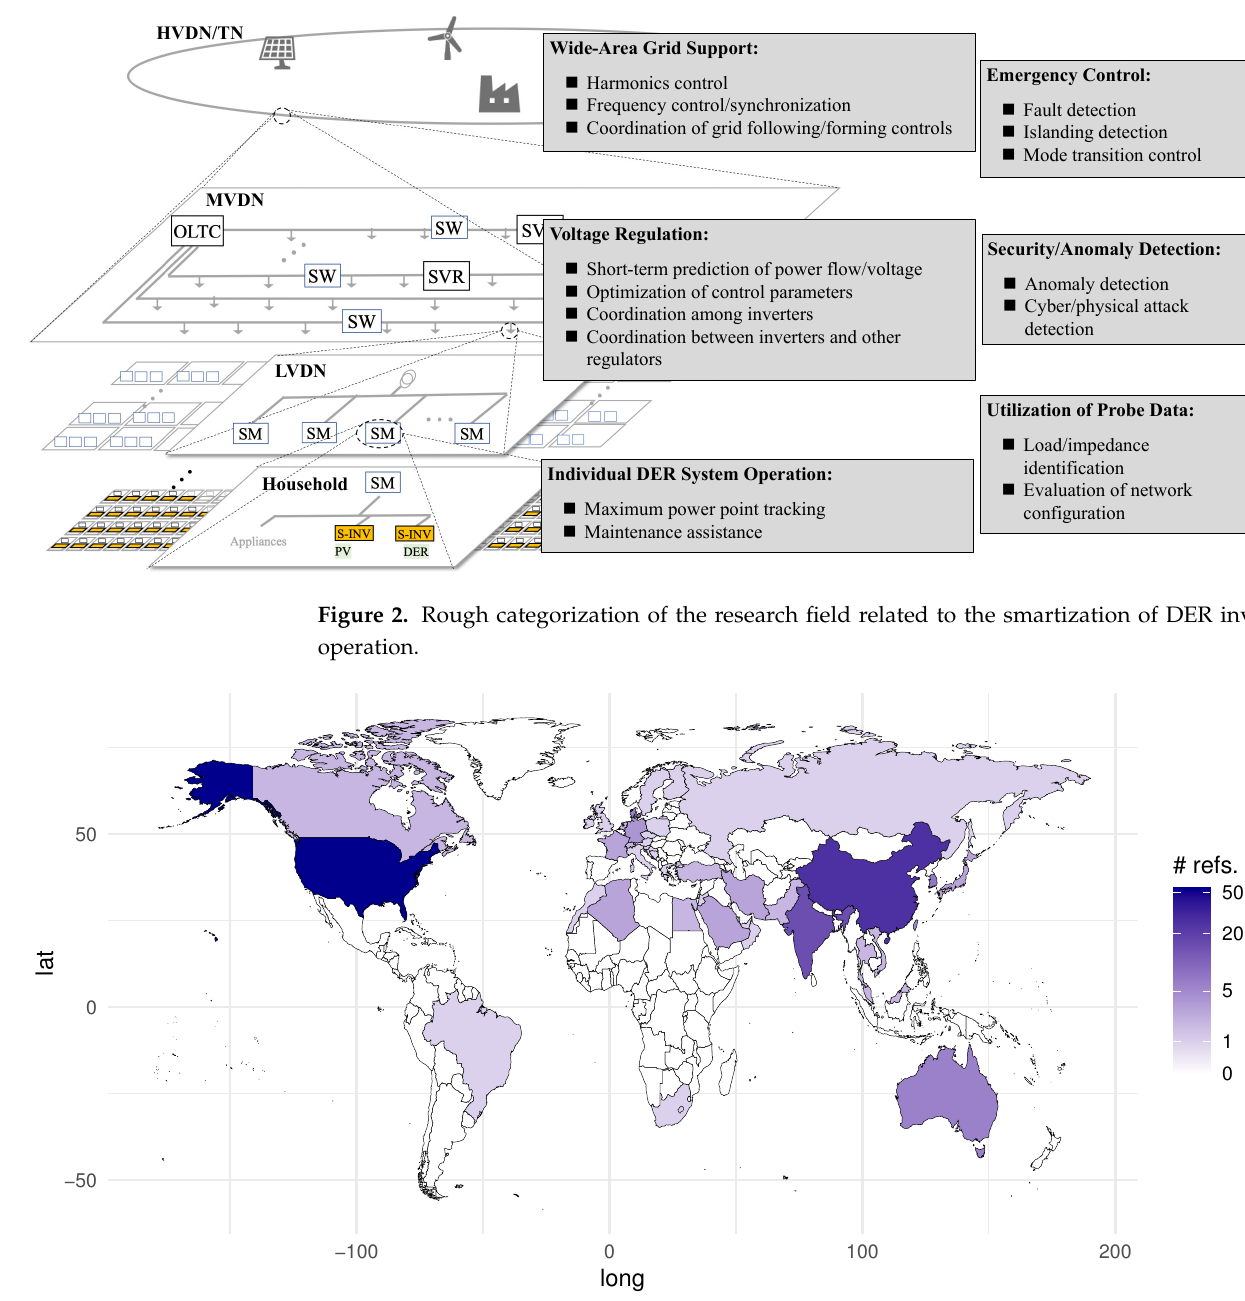
Figure 3. Locations of institutions where the authors of the literature reviewed in this study are affiliated. Color indicates the number of references presented in this